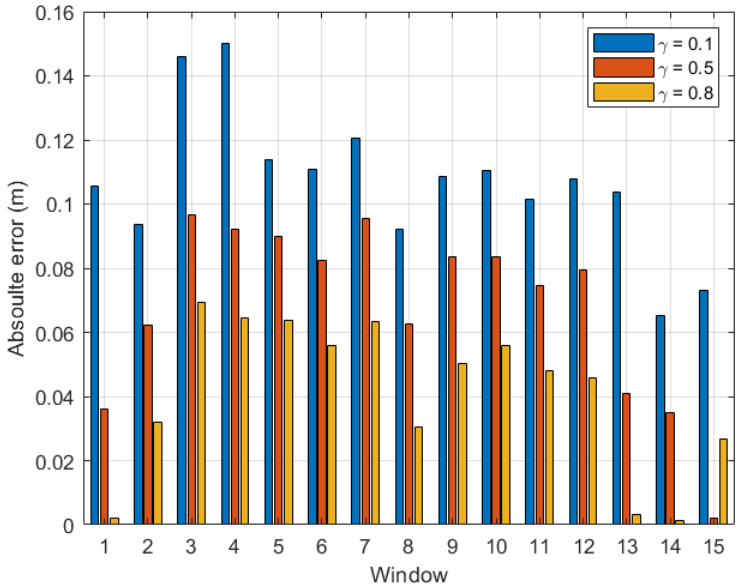
Figure 10. Outdoor walking (dataset 3): absolute error with respect to time windows tw i , i ∈ [ 1,15 ]